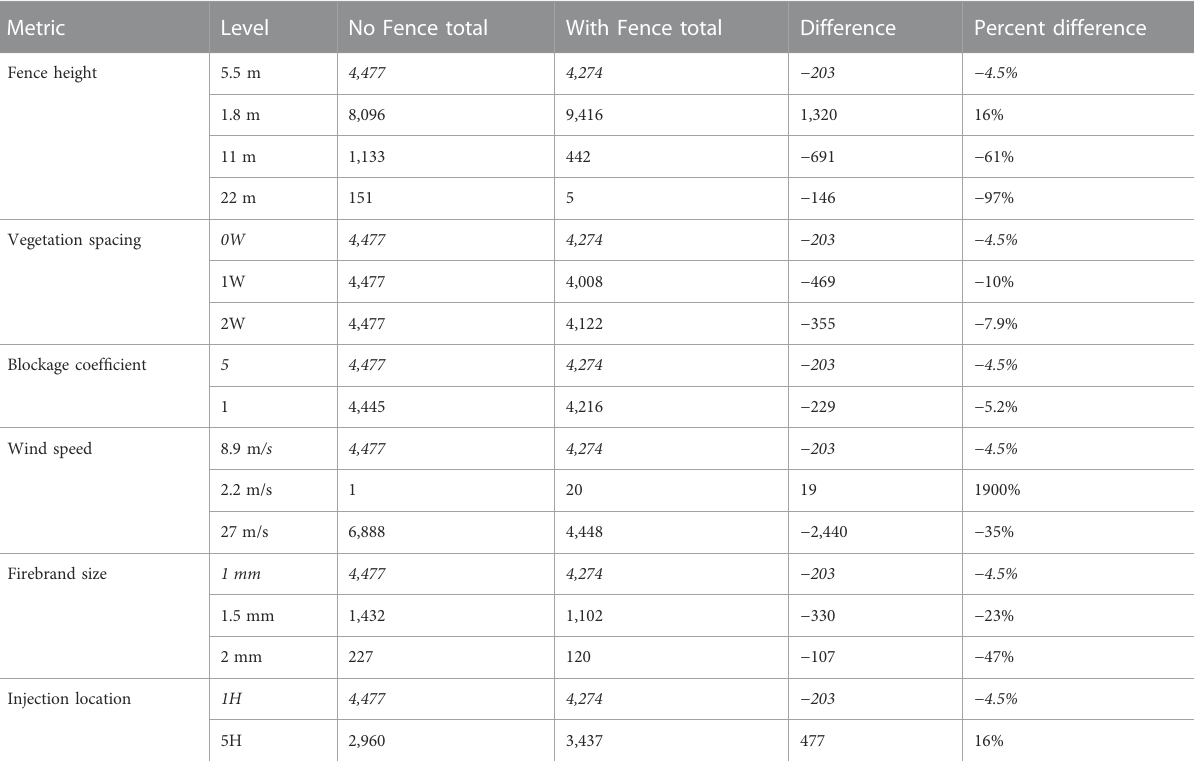
TABLE 3 Deposition totals and differences on the house for the sensitivity analysis cases. Positive numbers: increased total deposition compared to the no- fence case; negative numbers: decreased total deposition compared to the no-fence case; italics: base case values. Metric